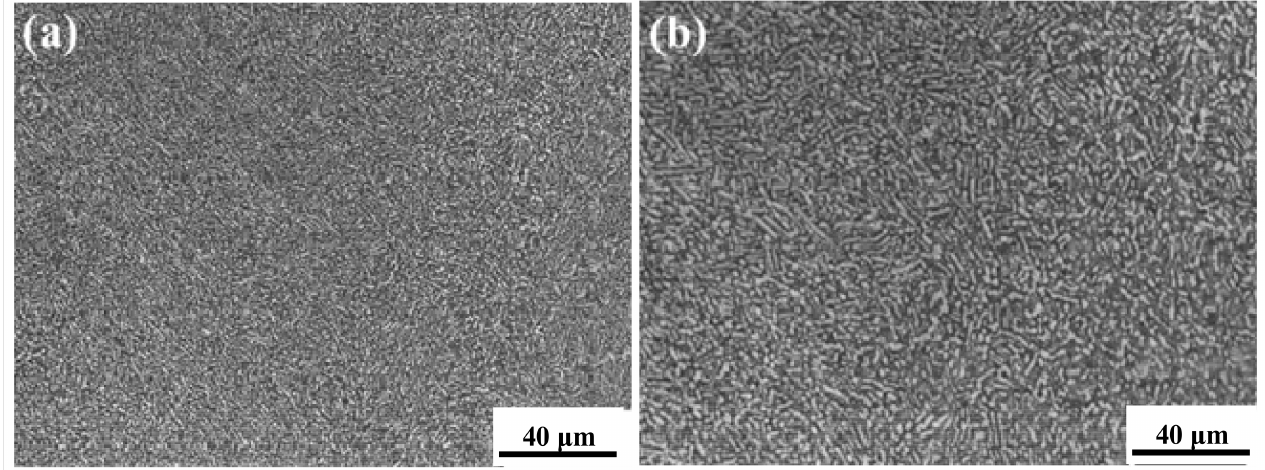
Figure 1. Optical images of the forged ( a ) SP700, ( b ) SP700 alloy after AC710, ( c ) SP700 alloy after AC800 and ( d ) SP700 alloy after AC820 + AC500.